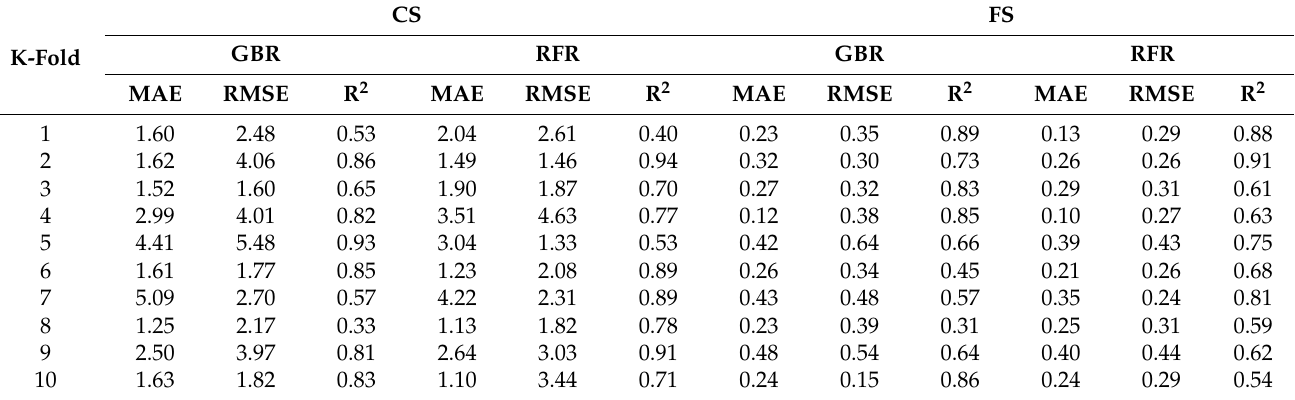
Table 3. Results of k-fold